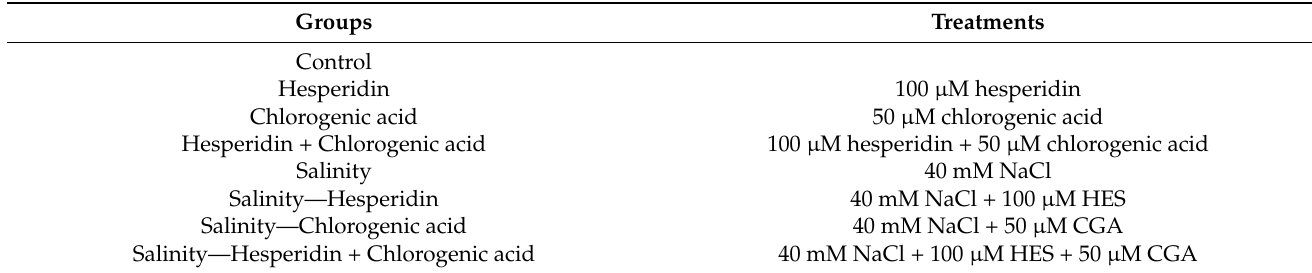
Table 4. The experimental design and plant growth